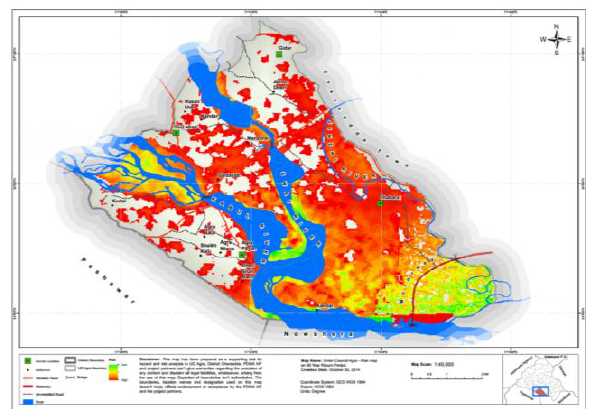
Figure 6. UC Agra- Risk map on 30-year return period Total agricultural area in the study area was 6362 acres where 100 years flood return period with high vulnerability ranking.